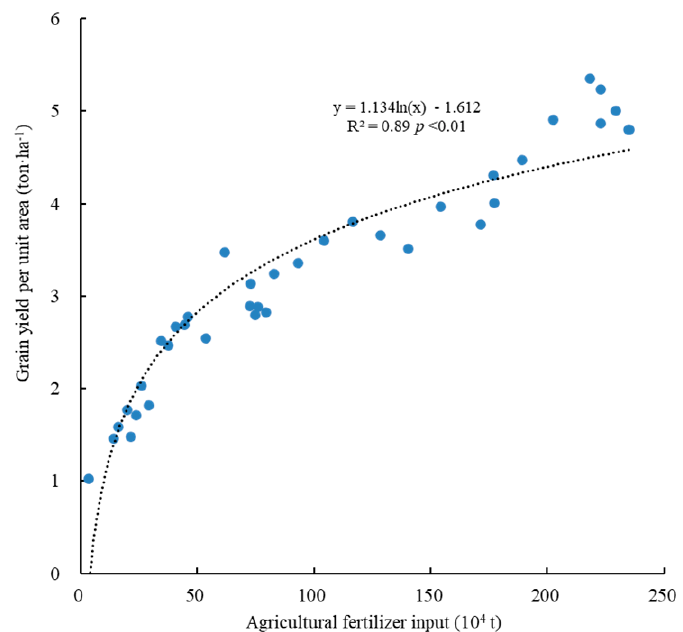
Figure 9. Yield and agriculture fertilizer input of Inner Mongolia Autonomous Region from 1980 to 2019.